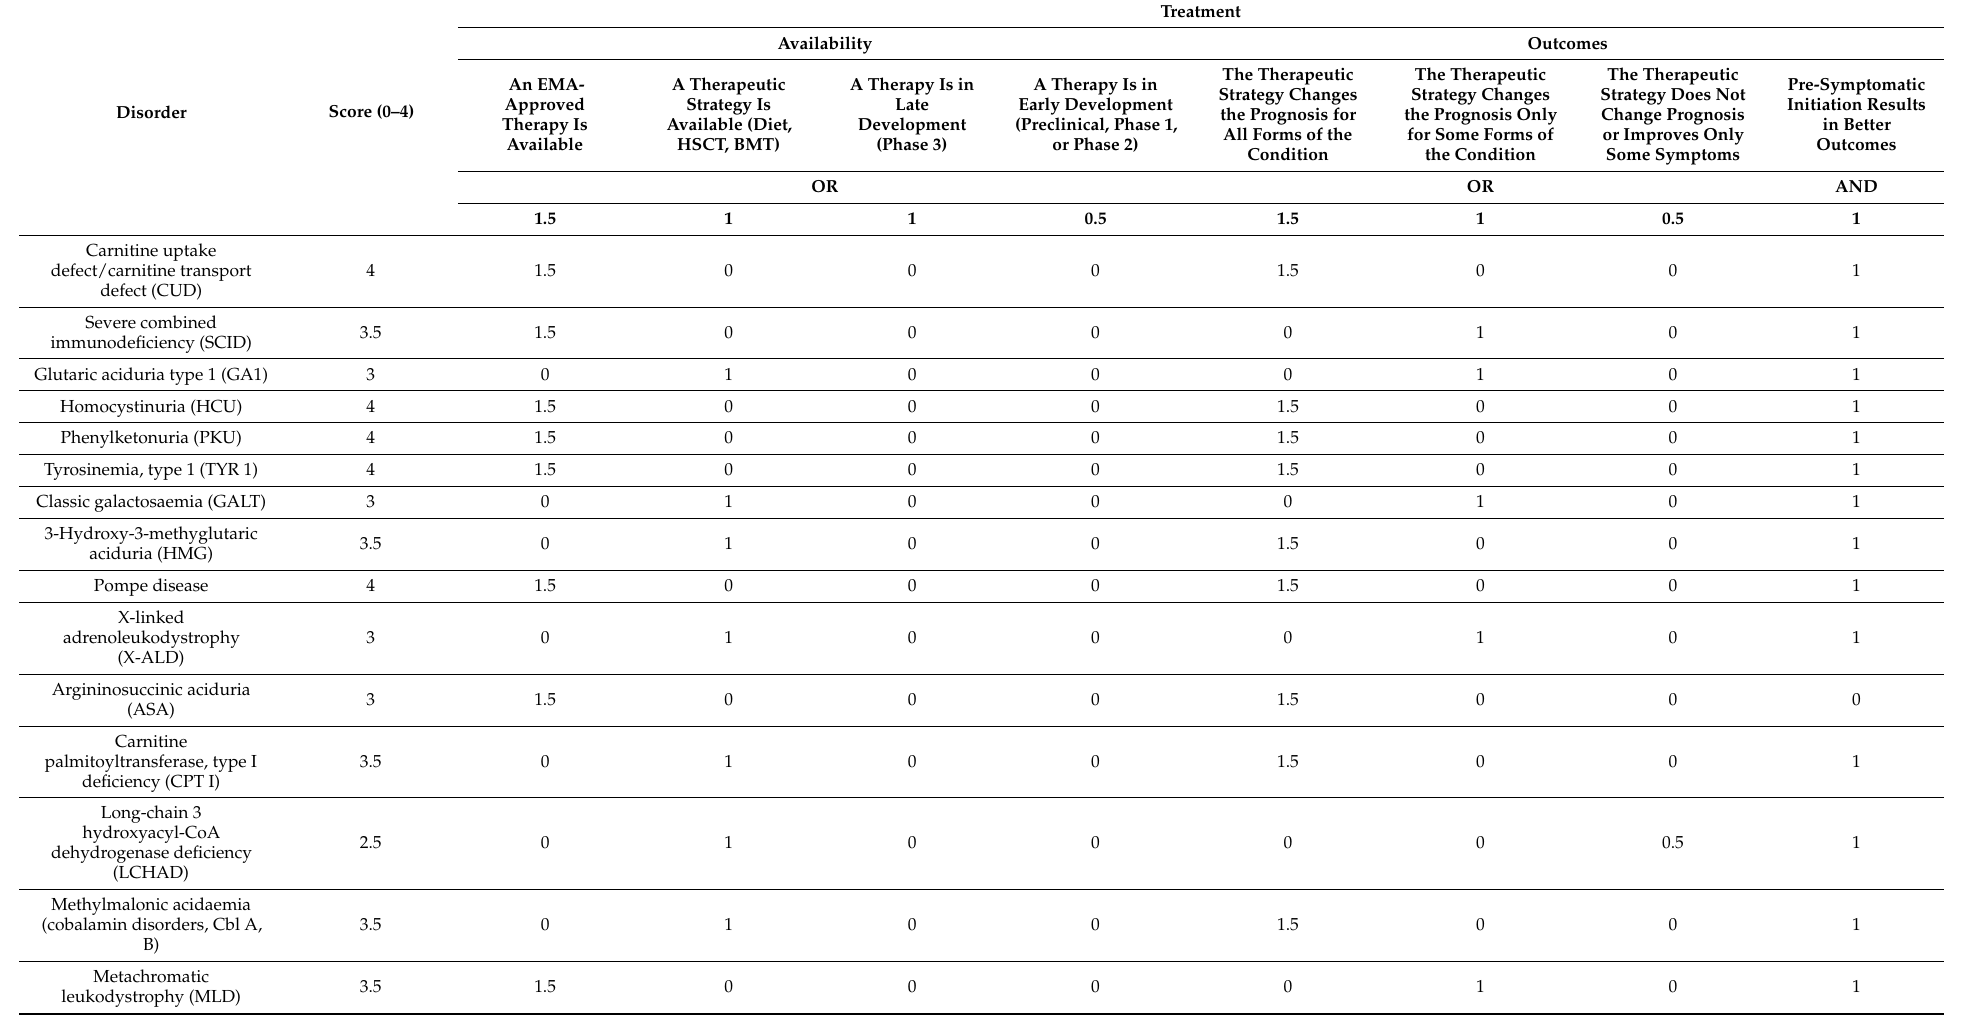
Table A4. Scoring of IMDs using the NBS evaluation algorithm: pillar Treatment